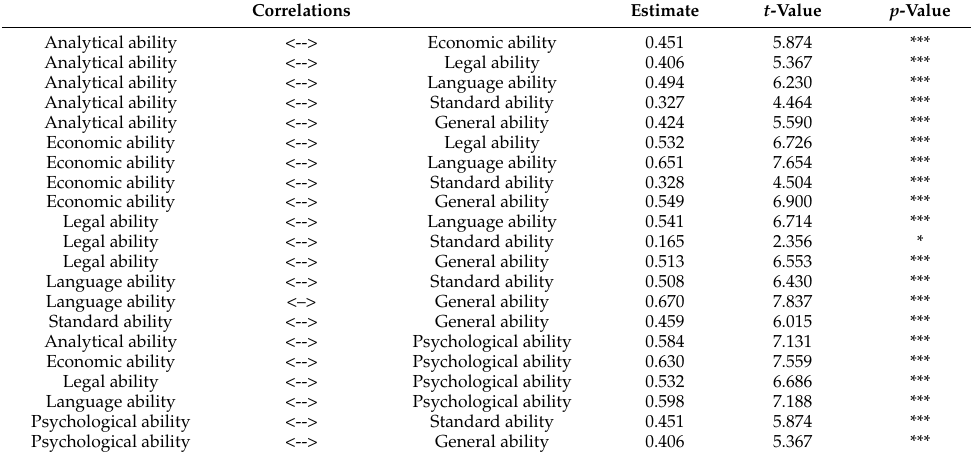
Table 7. Correlation